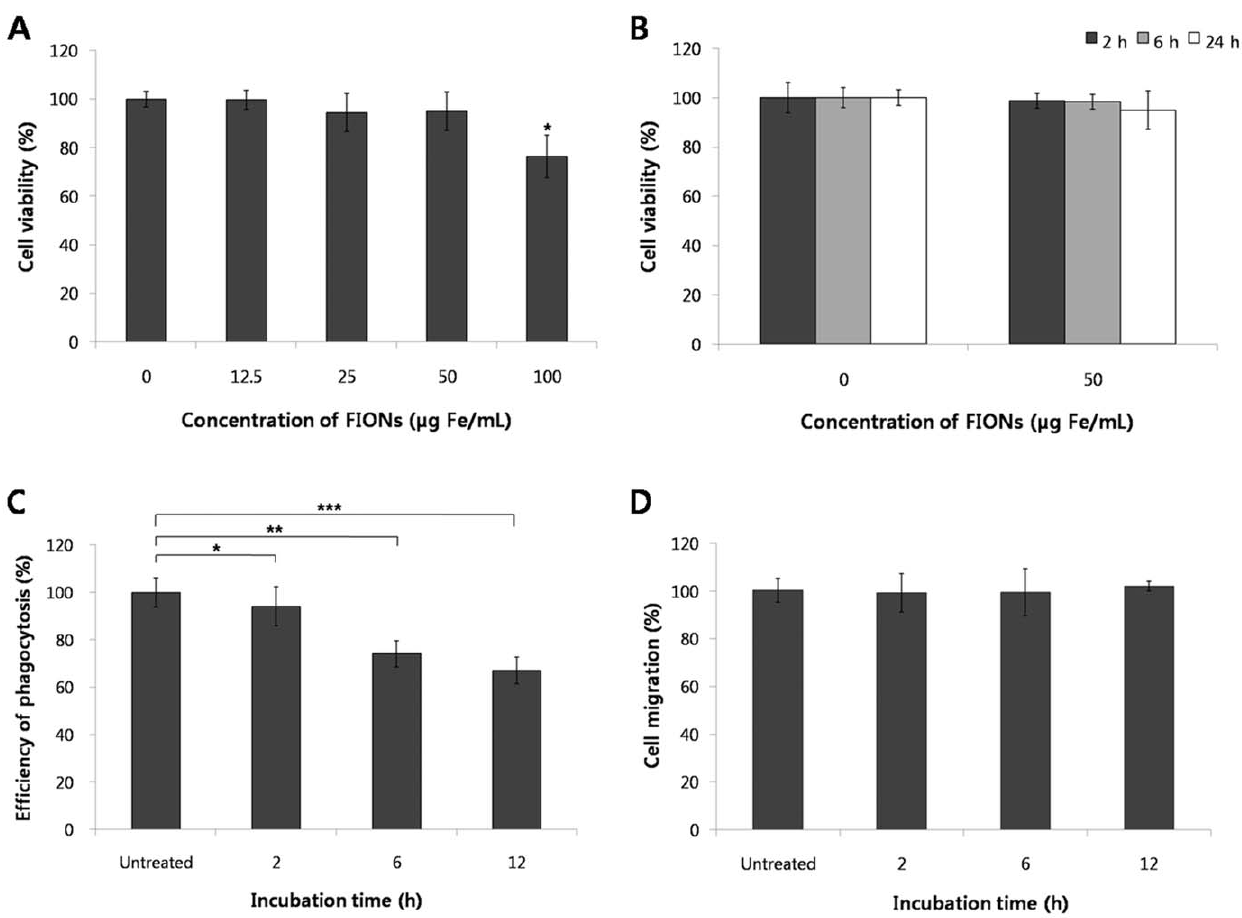
Figure 3. The physiological functions of macrophages after FIONs labeling. (A) Cell viability test of the macrophages after exposure to varying concentrations of the FIONs for 2 h. The cell viability at the concentration of 100 m g Fe/mL FION concentration was significantly lower than the other concentrations tested (* P , 0.001). (B) No significant differences in the cell viability were observed after treatment with FIONs (50 m g Fe/mL) for varying times ( P =0.5393). (C) The efficiency of phagocytosis decreased as the incubation time of the macrophages with the FIONs increased. Macrophages were incubated with FIONs (50 m g Fe/mL) at 37 u C for the indicated times, and the efficiency of phagocytosis was determined. The incubation times of 6 and 12 h showed significant differences when compared to the untreated group (* P . 0.05, ** P , 0.05, *** P , 0.01). (D) Macrophages were incubated with FIONs (50 m g Fe/mL) at 37 u C for the indicated times, and then a macrophage migration assay was performed. No statistically significant differences were evident between the untreated and the FION treated groups (50 m g Fe/mL). All experiments were analyzed using the ANOVA test and the Tukey-Kramer multiple comparison test.